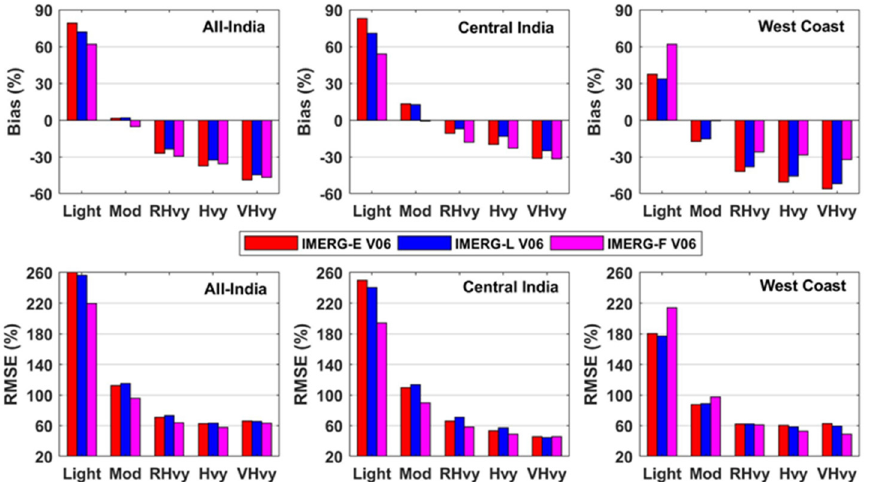
Figure 12. Bias and root mean square errors in the IMERG version 6 estimates as compared to the IMD rain-gauge-based data for 2014–2017 over all-India, central India, and west coast for different rainfall intensity